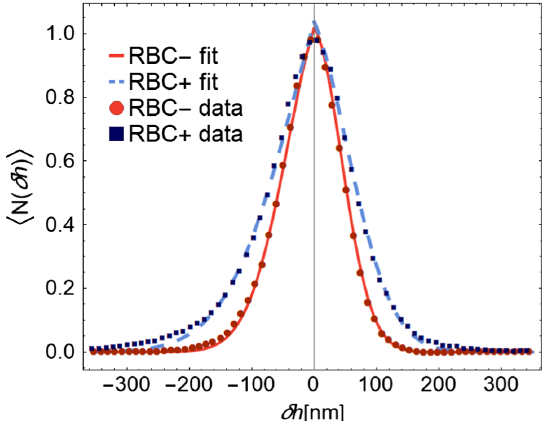
FIG. 9. Experimental data and the corresponding theoretical fits [Eq. (27)] of the RBC membrane fluctuations [23]. RBC- denotes the RBCs depleted of ATP, while RBC þ denotes RBCs enriched with ATP. Negative δ h correspond to the extracellular side of the distribution, while positive δ h correspond to the intracellular